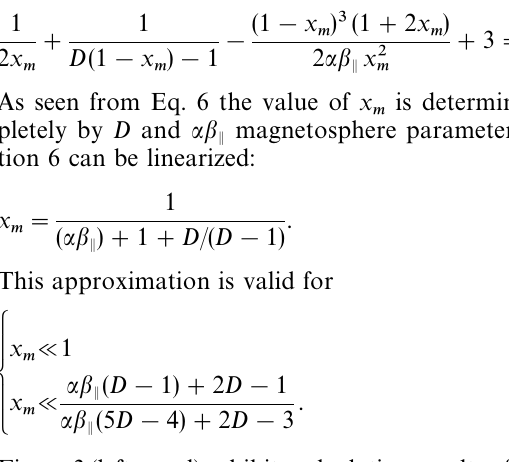
(cid:109) given by Eq. 6 and x (cid:109) obtained from its linear approximation (Eq. 7) for two values of D . As seen in the figure, Eq. 8 allows us to estimate the values of x (cid:109) with good accuracy. On the right panel of Fig. 3 the undisturbed frequency of maximum emission intensity as a function of D and (cid:97)(cid:98) (cid:69) is shown. Figure 3 indicates the area where x (cid:109) is the most sensitive to D and (cid:97)(cid:98) (cid:69) increments. This area is located near low D and low (cid:97)(cid:98) (cid:69) values. Note that drop- ping the x (cid:109) (cid:48) value with decreasing the factor D in Fig. 3 is in agreement with Eq. 4, which corresponds to the critical anisotropy defined by Kennel and Petscheck (1966). As seen within the considered D and (cid:97)(cid:98) (cid:69) ranges, x (cid:109) (cid:48) remains small as compared to